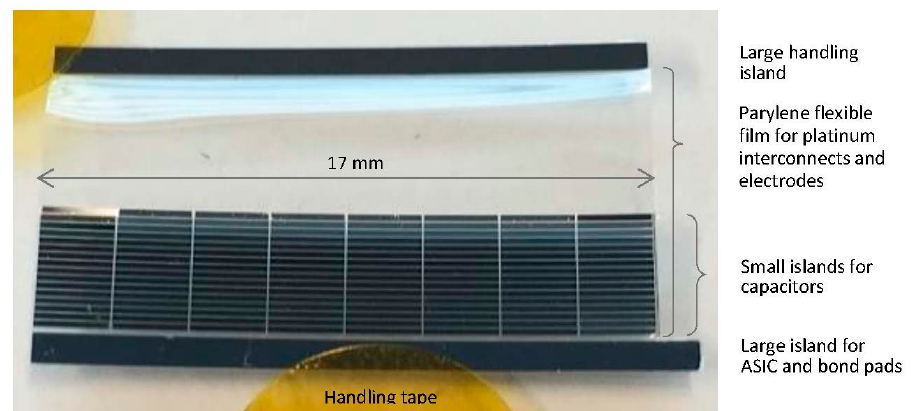
Figure 3. Top-view photography of the 80 µm thin released device composed of small (2.000 µm × 200 µm) and large (17 mm × 1 mm and 18 mm × 1.1 mm) silicon islands separated by 40 µm wide trenches and connected with the 10 µm thick parylene-based flexible interconnect.